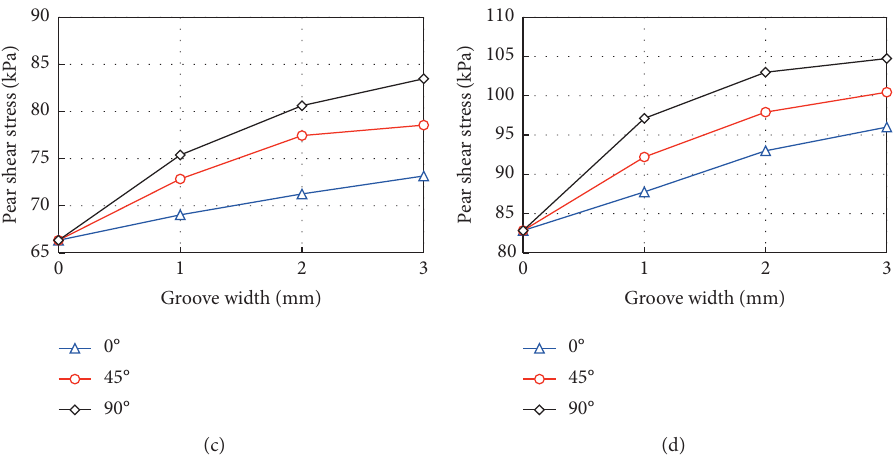
Figure 9: Peak shear stress-groove width relationship for the steel-sand interfaces. (a) 50kPa. (b) 100kPa. (c) 150kPa. (d) 200kPa. Table 2: Increasing extent of peak shear stress with groove angle.